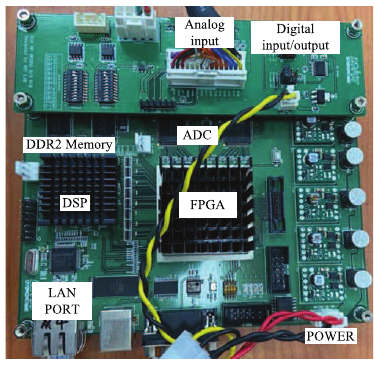
Figure 13. Back-end module (BEM).